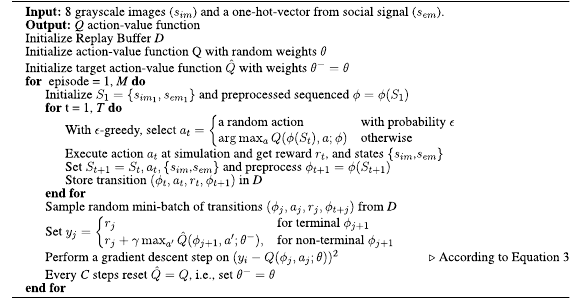
Algorithm 1. SocialDQN pseudo